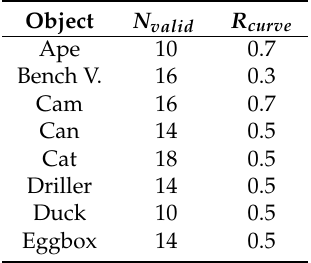
Table A1. Parameters of the ACCV